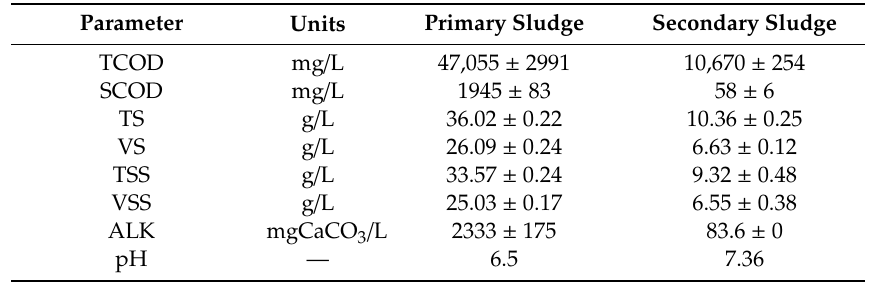
Table 4. Substrate